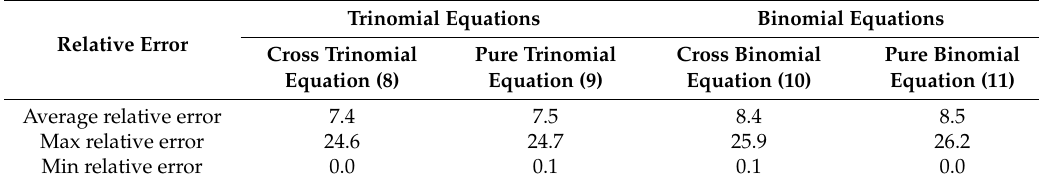
Table 3. Relative errors between predicted and measured blasting crater